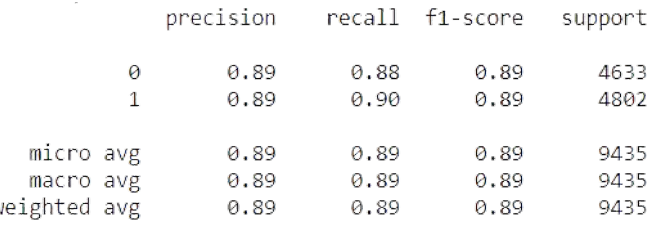
Figure 16. Support Vector Machines metrics.